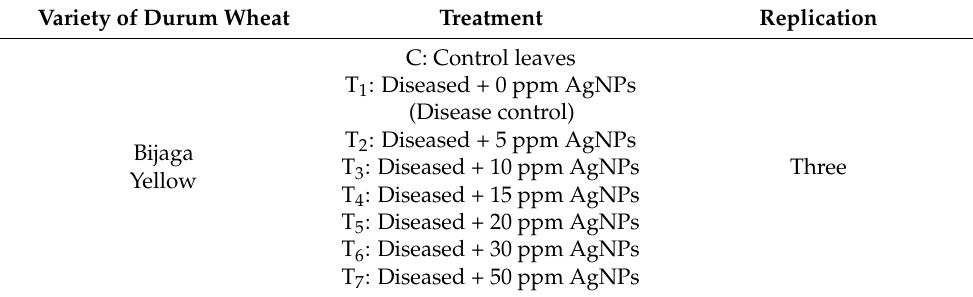
Table 1. Details of the treatment groups used in the study. Variety of Durum Wheat Treatment Replication C: Control leaves T 1 : Diseased + 0 ppm AgNPs (Disease control) T 2 : Diseased + 5 ppm AgNPs Bijaga T 3 : Diseased + 10 ppm AgNPs Yellow T 4 : Diseased + 15 ppm AgNPs T 5 : Diseased + 20 ppm AgNPs T 6 : Diseased + 30 ppm AgNPs T 7 : Diseased + 50 ppm AgNPs